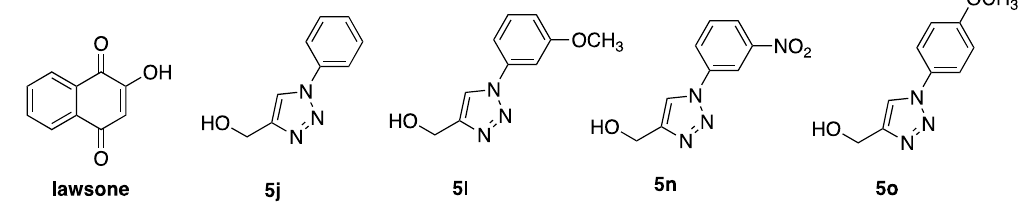
Figure 2. Structures of simplified fragments of 1,2,3-triazole-naphthoquinones.